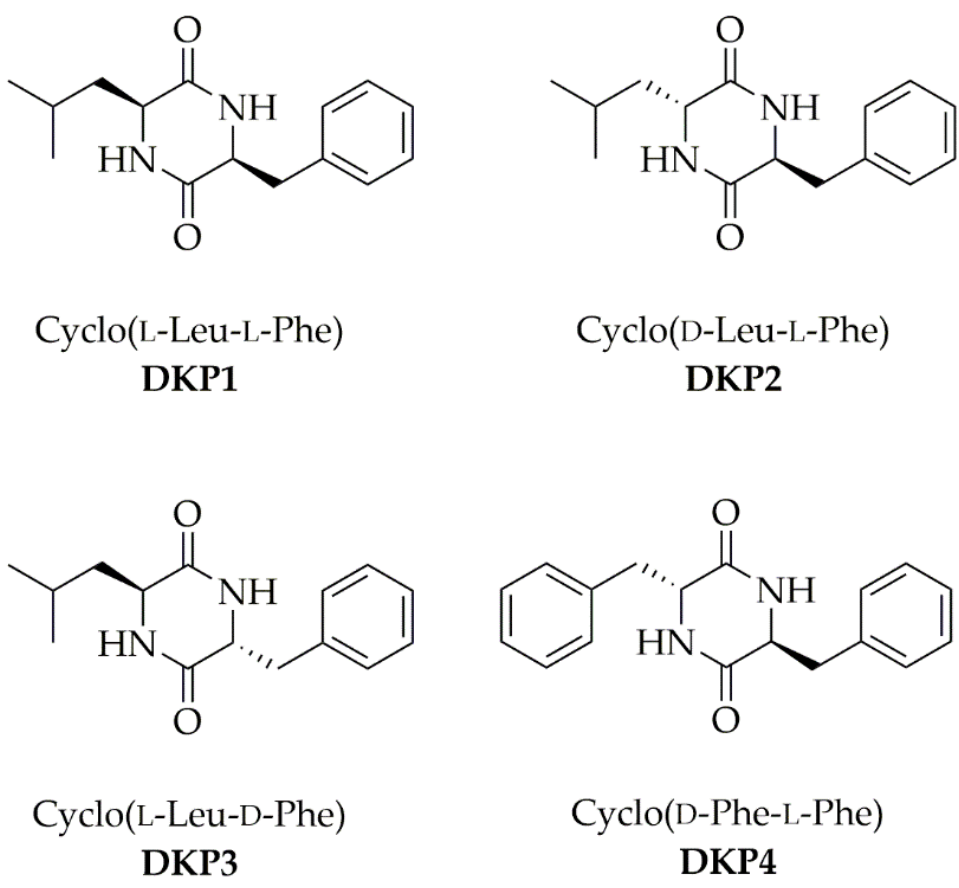
Figure 1. Four cyclodipeptides or DKPs used in this work. Table 2. NMR shifts in deuterated DMSO of α CH and β CH protons of DKPs 1–4. Values in bold indicate upfield shifts due to intramolecular CH- π